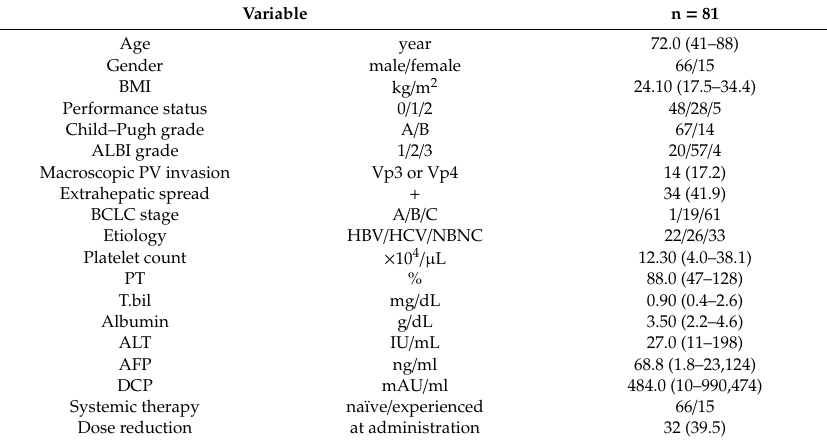
Table 1. Characteristics of the patients enrolled in the present